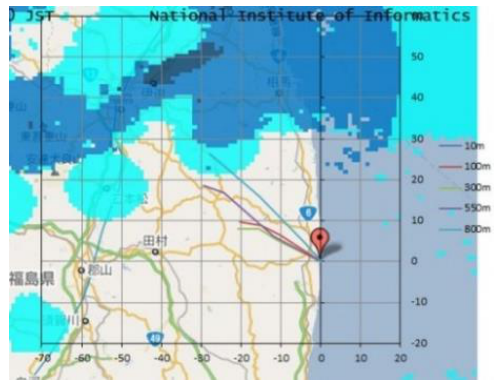
Figure 6. Flying particles and rain clouds at 21:00